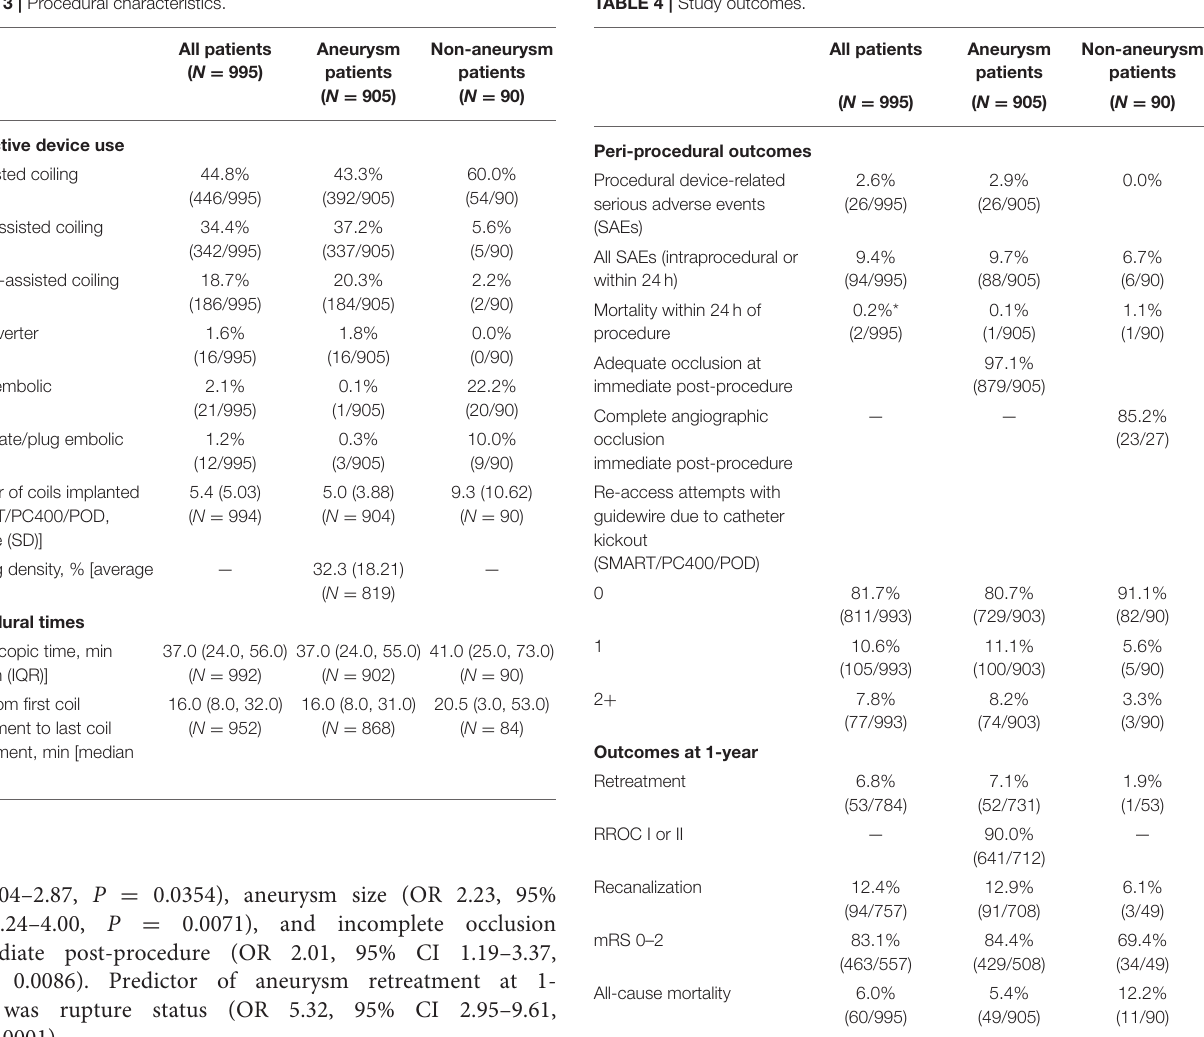
TABLE 3 | Procedural characteristics. TABLE 4 | Study